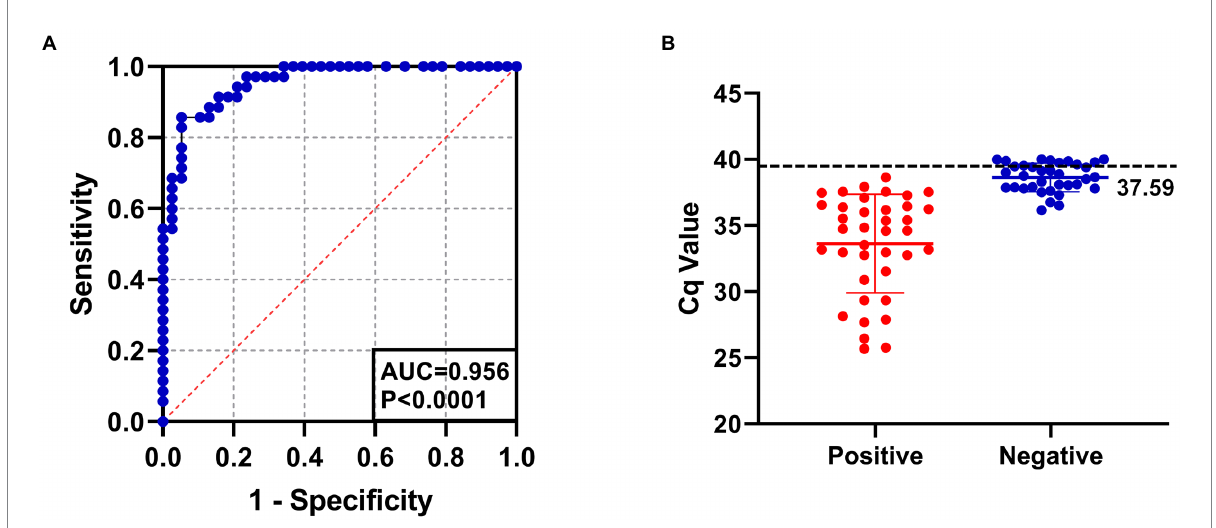
TABLE 3 Positive rate of GETV in five species of animals in five cities in Shandong Province. Species Total (%)